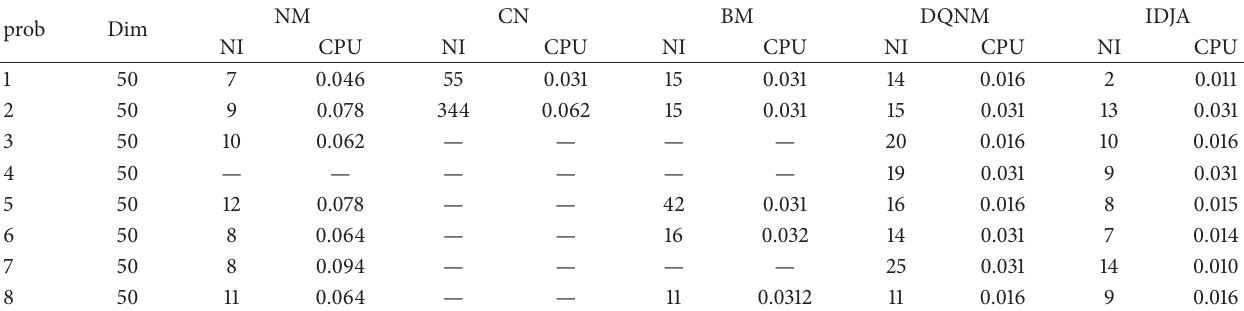
Table 1: Numerical results of NM, CN, BM, DQNM, and IDJA